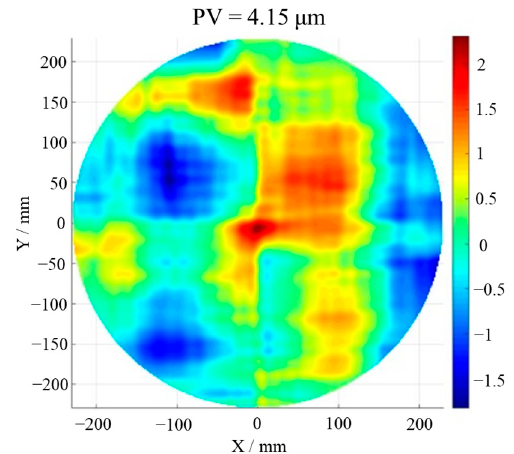
Figure 19. Figure of SiC aspheric mirror after grinding.